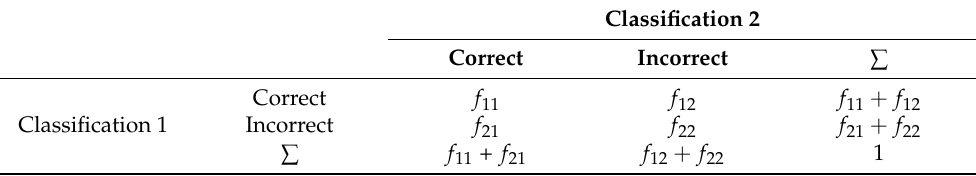
Table 5. Contingency table for McNemar test between two classification